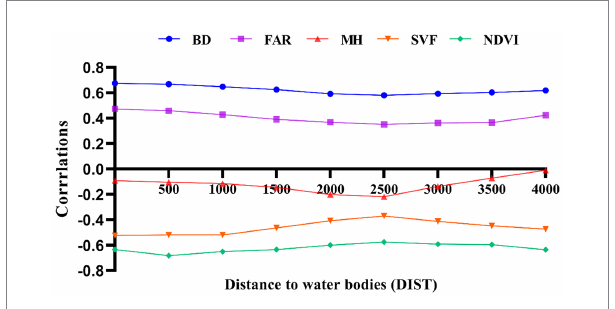
FIGURE 4 Pearson correlation coefficient LST— urban morphological factors.